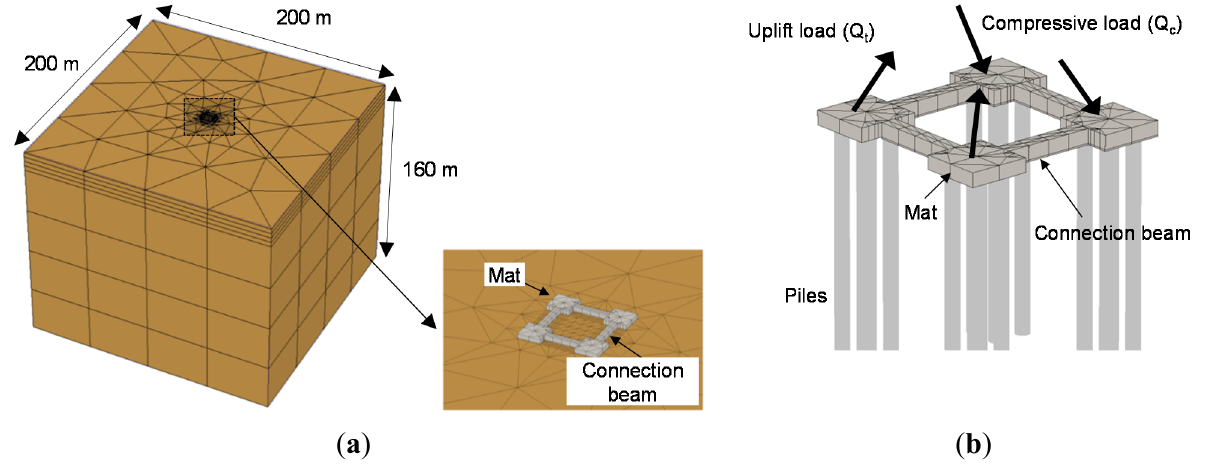
Figure 4. Finite element model for transmission tower foundation: ( a ) configuration of connected foundation model and ( b ) configuration of applied